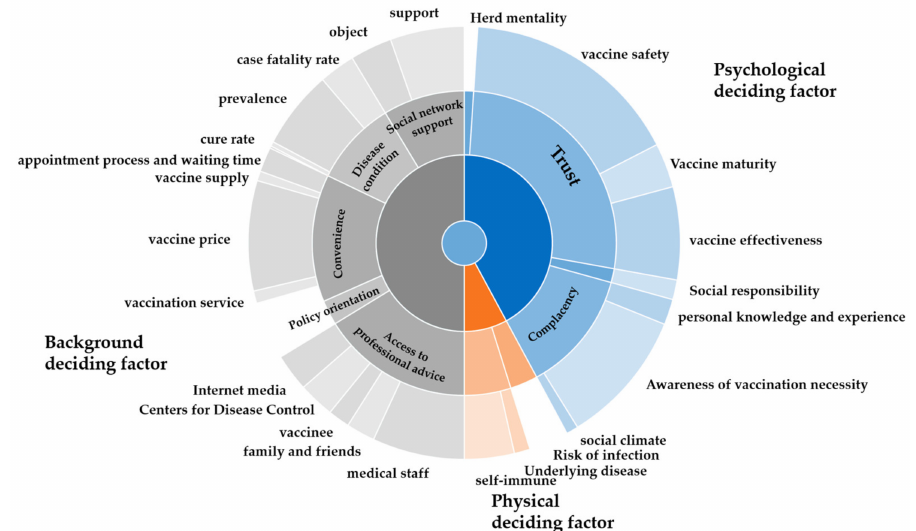
Figure 1. Wheel diagram of factors influencing vaccine hesitancy in